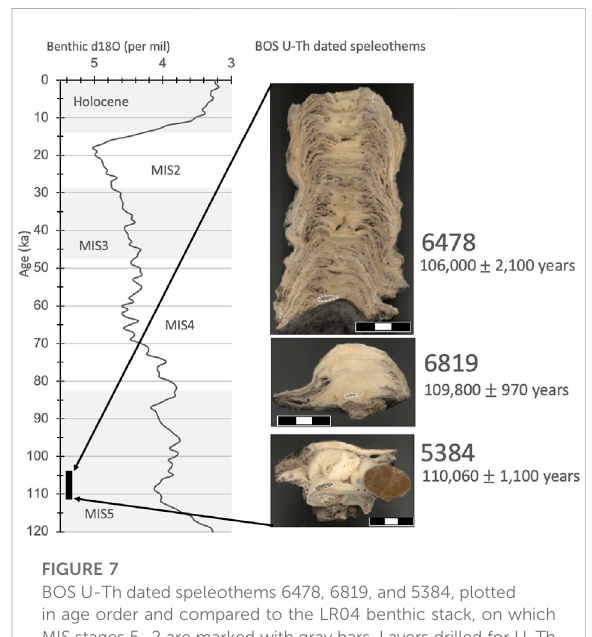
FIGURE 7 BOS U-Th dated speleothems 6478, 6819, and 5384, plotted in age order and compared to the LR04 benthic stack, on which MIS stages 5 – 2 are marked with gray bars. Layers drilled for U-Th dating are marked with dashed freeforms, and the scale bar is 3